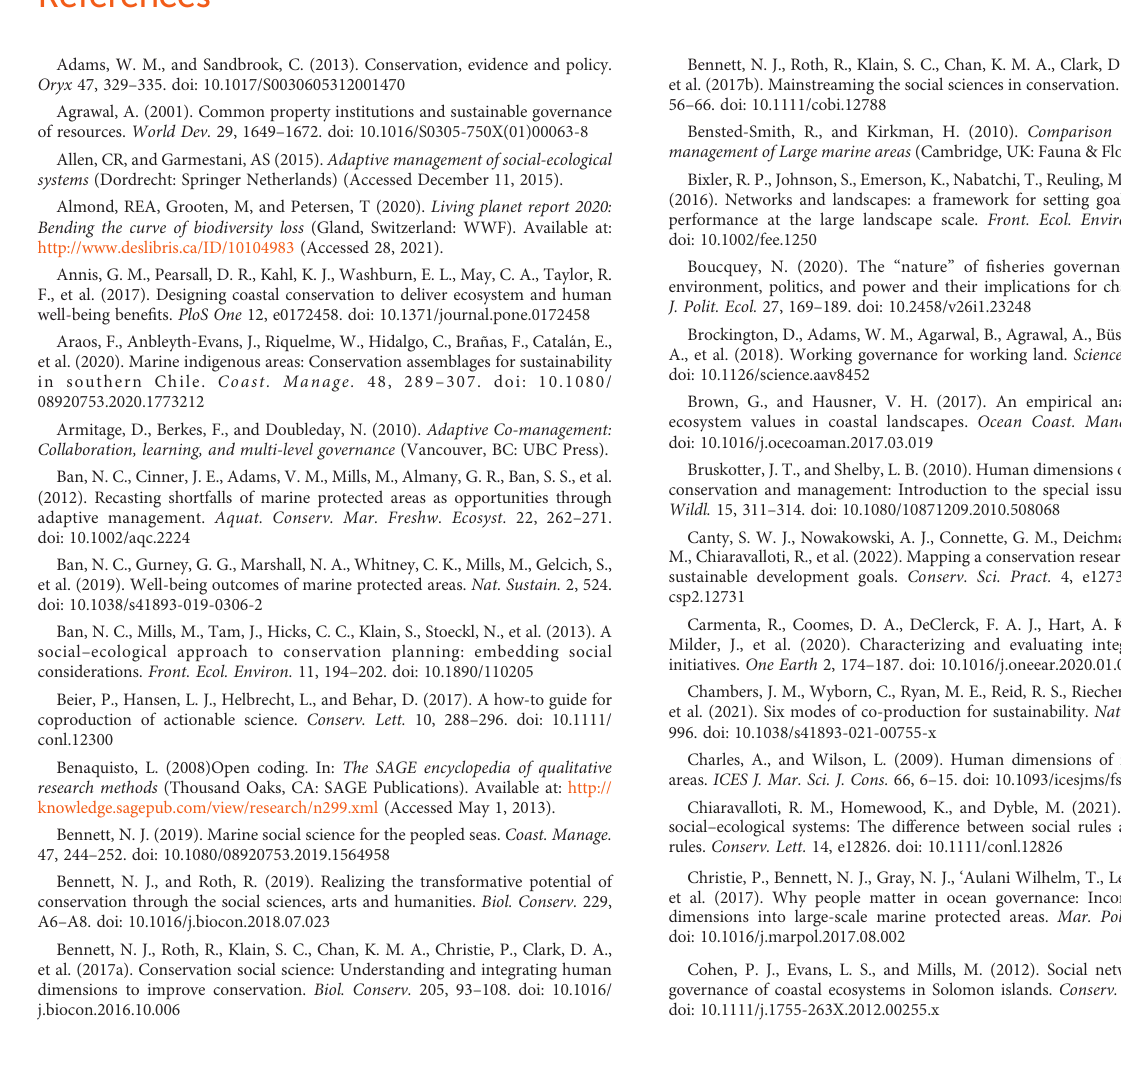
Figure 3 was created by Sarah Wheedleton. This is Smithsonian Marine Station contribution number